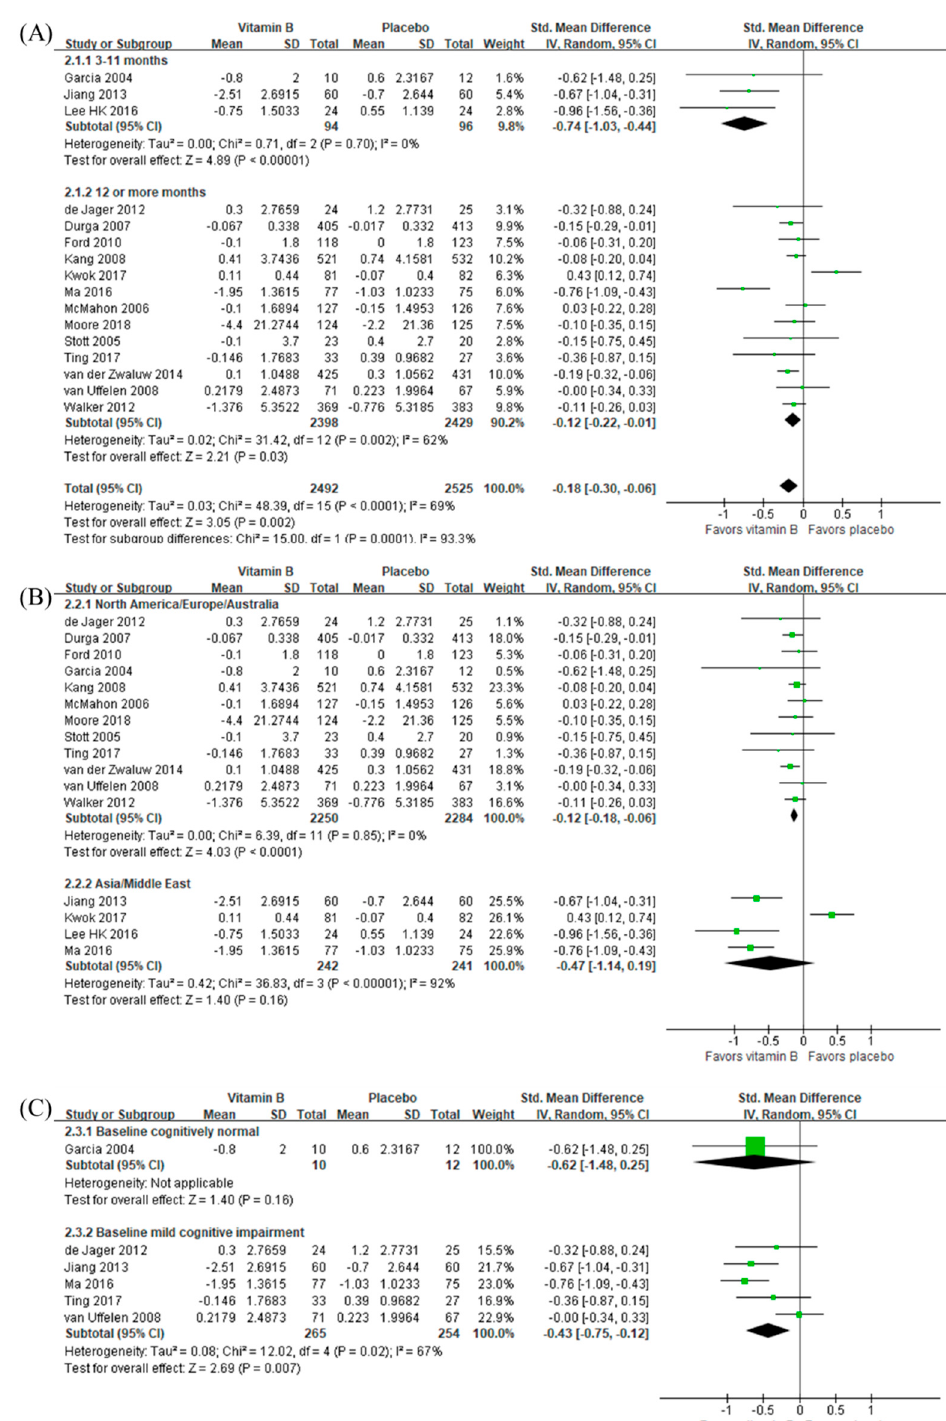
Figure 2. Effect of B vitamins on global cognition in terms of change from baseline by (A) the length Figure 2. E ff ect of B vitamins on global cognition in terms of change from baseline by ( A ) the length of of the intervention period, (B) the geographic location of the study, and (C) baseline cognitive the intervention period, ( B ) the geographic location of the study, and ( C ) baseline cognitive function.